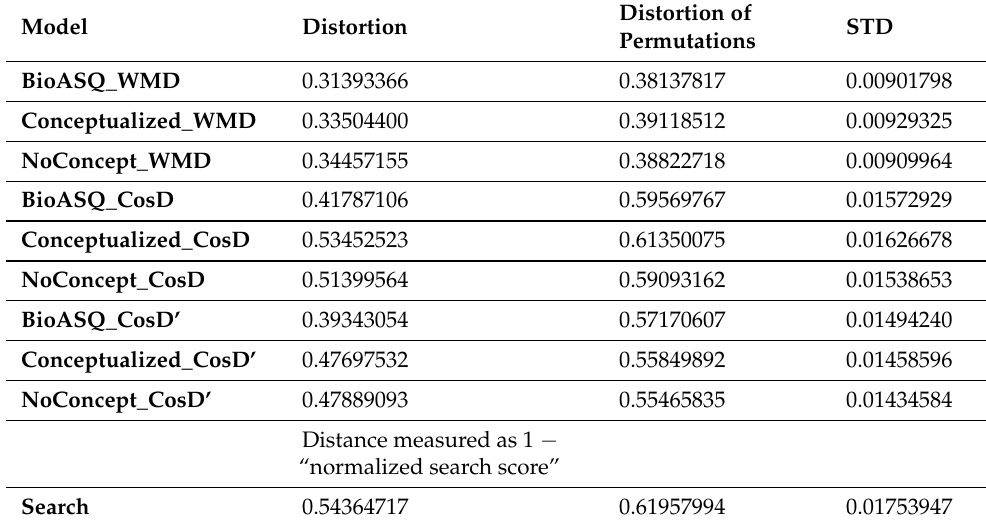
Table 6. This table shows the values obtained in multiple experiments. Column 2, Distortion , shows the distortions of graphs produced using corresponding models from Column 1. Average distortions per permutation are shown in Column 3. STD is the standard deviation of the distortion per permutation of vertices. Note that the distortion is somewhat depended on how we measure distances; however, the shapes of the distributions are very similar. (The cosine measures are capitalized for